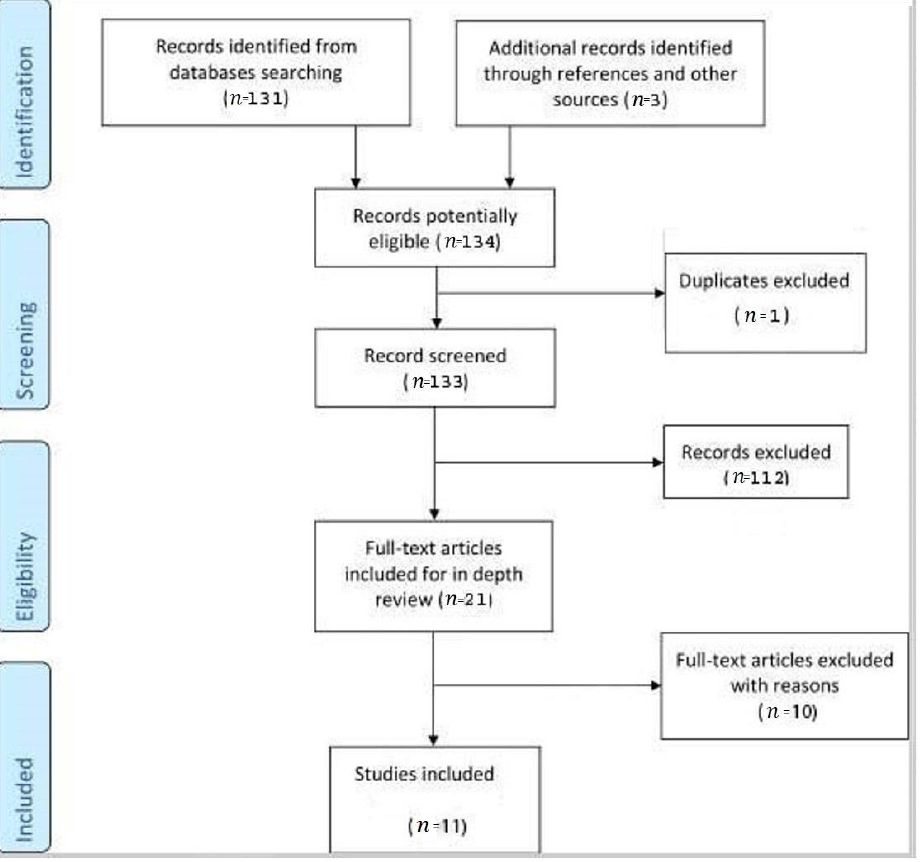
Figure 1. Flowchart illustrating the selection of reports included in the analysis.